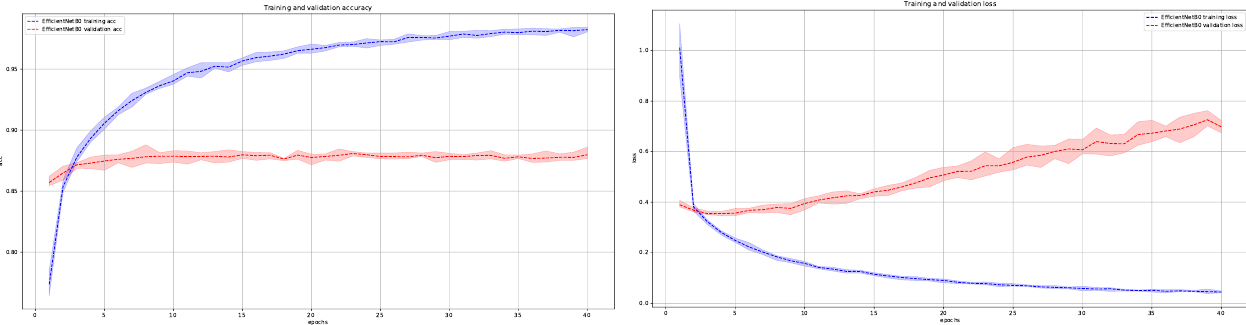
Figure 7. Average training and validation accuracy ( left ) and loss ( right ) during training of EfficientNetB0 for five times with maximal and minimal deviation areas marked in color (blue for training and red for